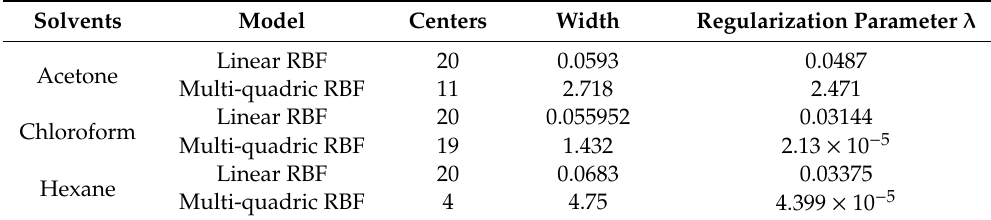
Table 2. QRBF parameters